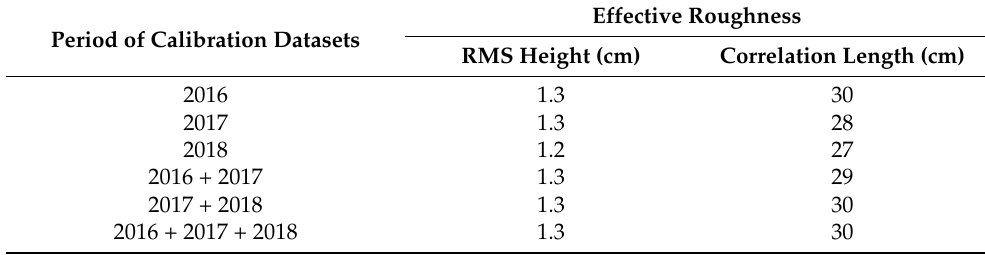
Table 3. Effective roughness parameters optimized at different temporal